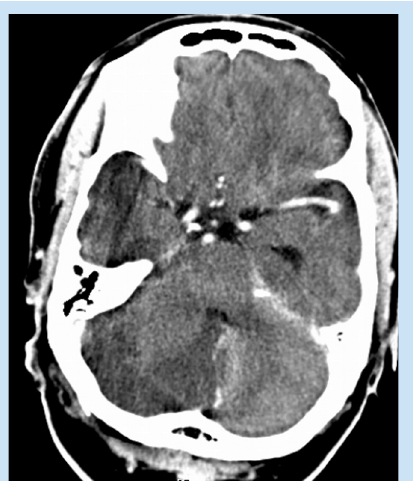
Fig. 1. Contrast-enhanced CT scan demonstrates a large non-enhancing intra-axial mass in the right cerebellum with a large temporal horn of left later- al